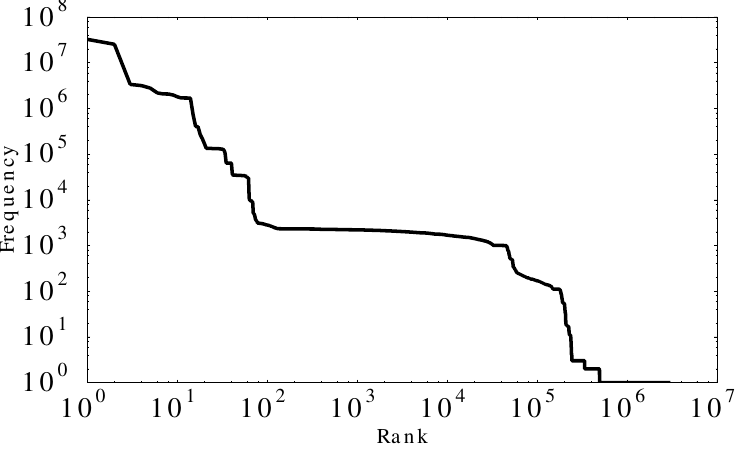
Figure 5. Frequency–Rank profile for